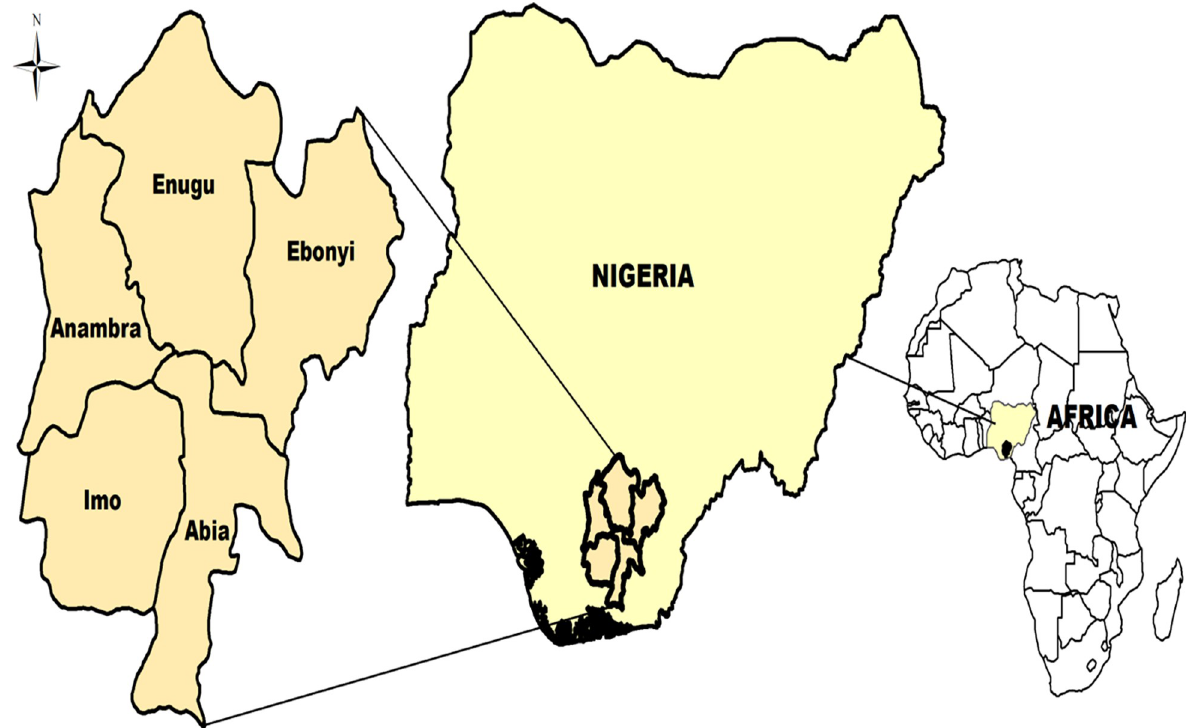
Fig 1. Map of Nigeria highlighting the Southeast geopolitical zone surveyed in this study.